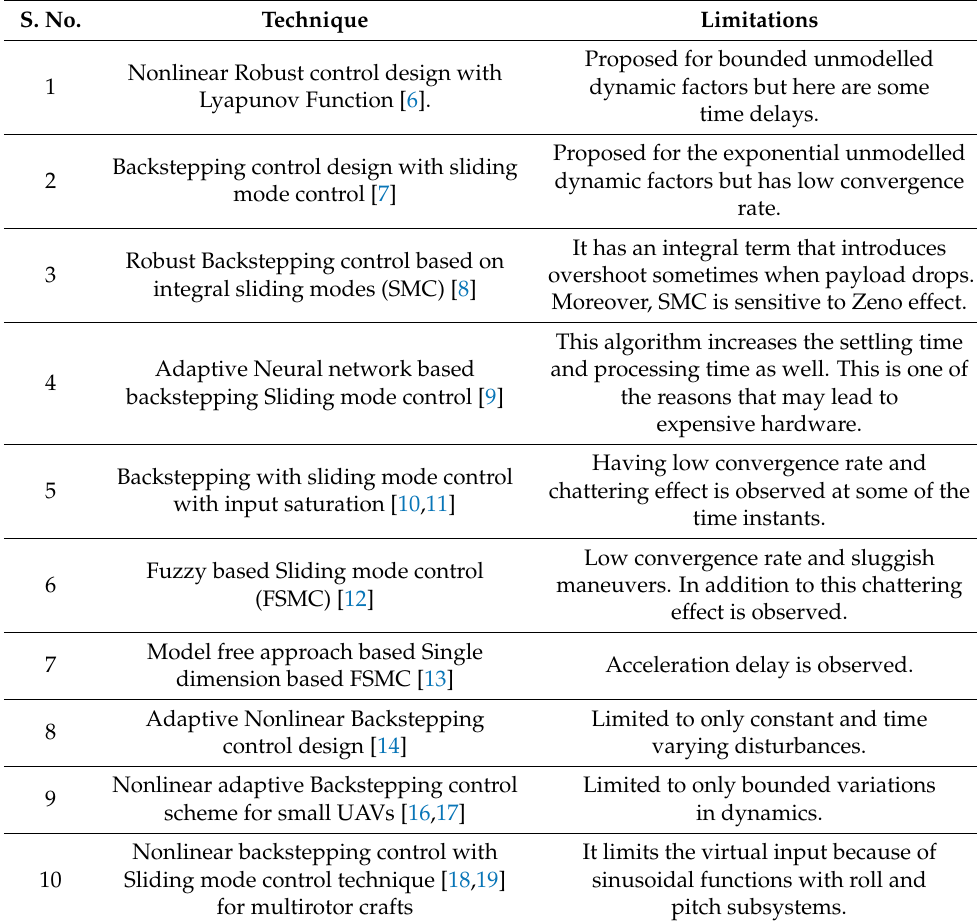
Table 1. State of the Art Approaches with